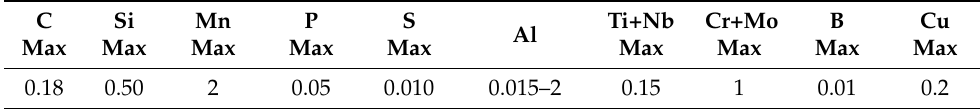
Table 1. Chemical composition, heat analysis in mass%.